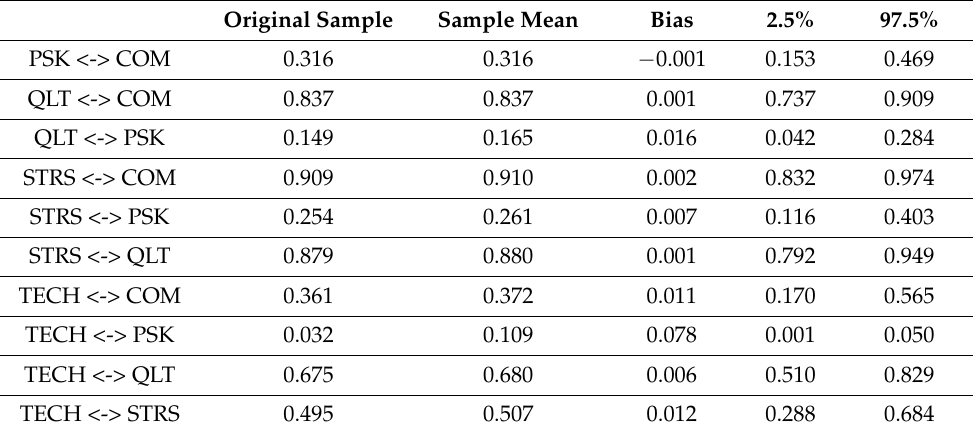
Table 6. HTMT with corrected confidence interval